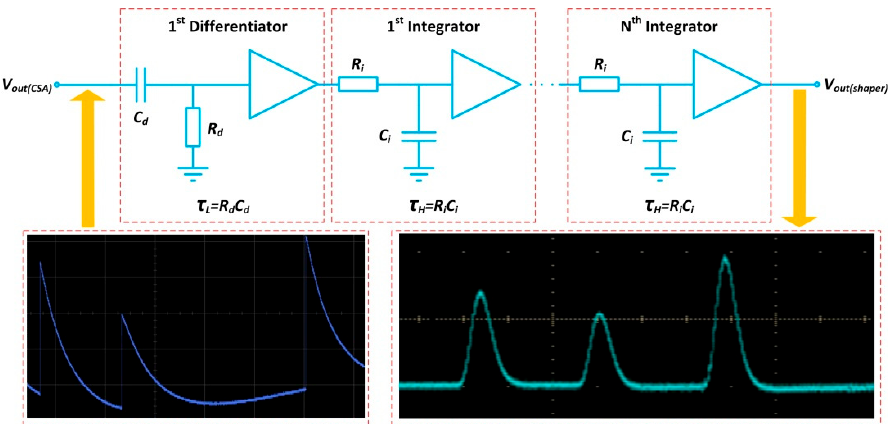
Figure 8. Circuit topology of the pulse shaper. The oscillogram in the red dotted box at the bottom left shows several long-tail pulses from the CSA. Correspondingly, some quasi-Gaussian pulses with the peaking time τ p in the red dotted box at the bottom right can be generated at the shaper output end.